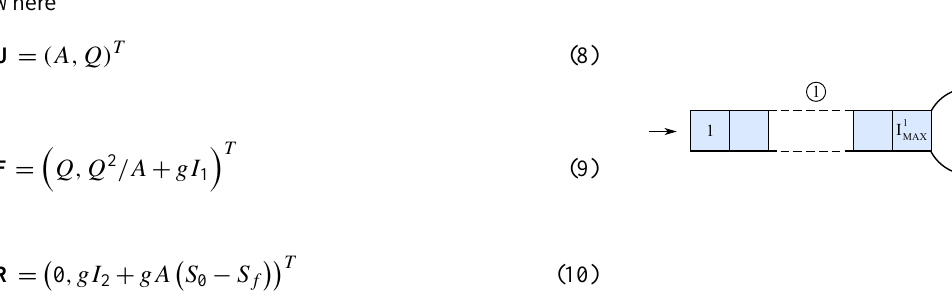
Figure 2. (a) Pure shallow flow (b) Pressurized pipe. 3 Preissmann slot model